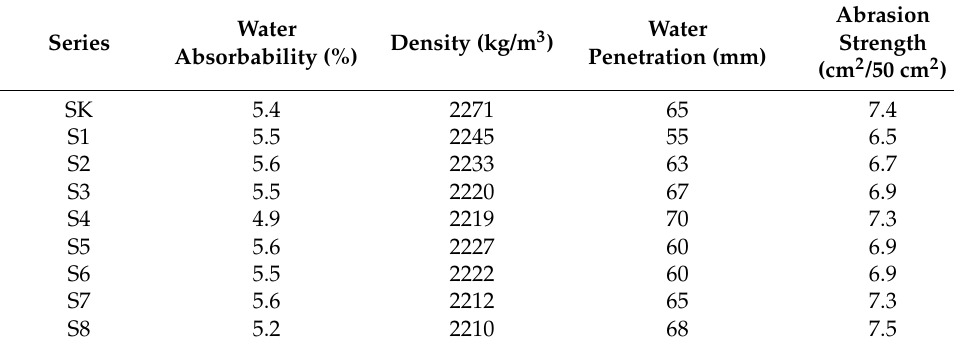
Table 6. Tested parameters for individual concrete